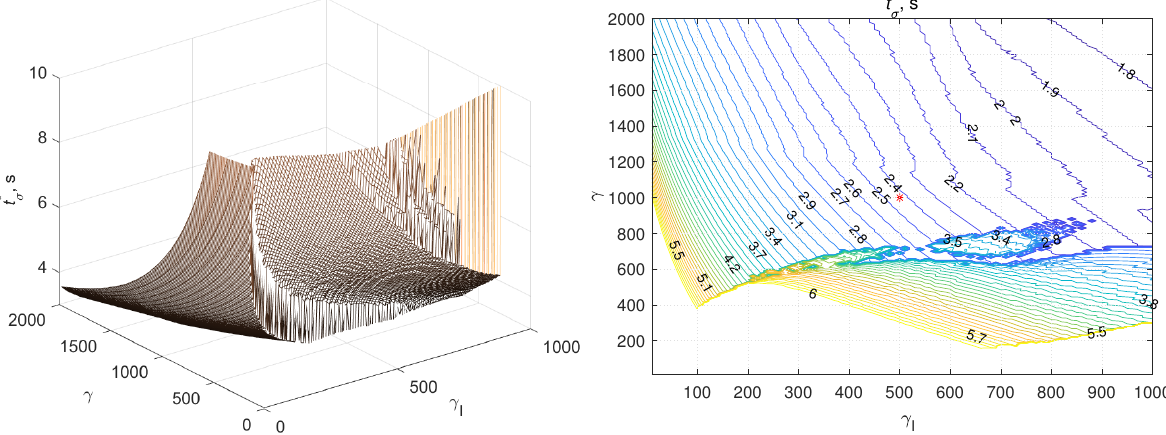
Figure 18. Simulations results. Dependence of t ∗ σ on controller gains γ , γ i for “nominal” plant parameters; ω ∗ = 60 rad/s, ψ ∗ = π . Left : 3D plot, right : contour plot; asterisk (cid:63) is for γ = 1000, γ I =